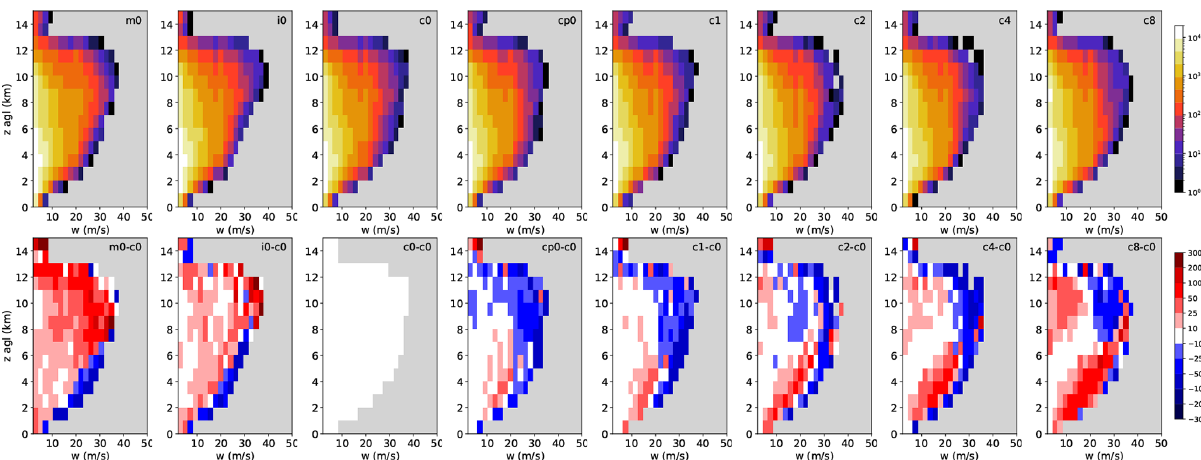
Figure 14. Frequency of updraft grid points as a function of height and updraft magnitude (top row) and frequency difference in percent, with respect to the reference run (bottom row) on 9 June